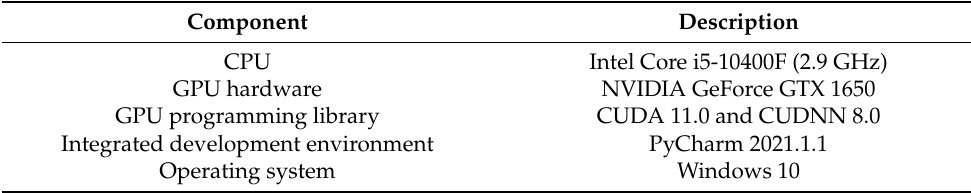
Table 3. Hardware and software configurations for model